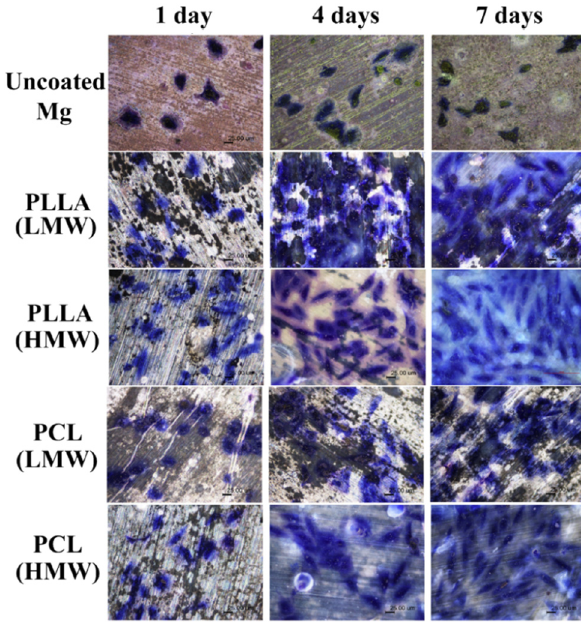
Figure 11: Biodegradable polymer fi lm was coated on Mg samples using magnesium by spin coating, and cells were cultured with these di ff erent samples for 1, 4 and 7 days ( reproduced from ref. [ 95 ])